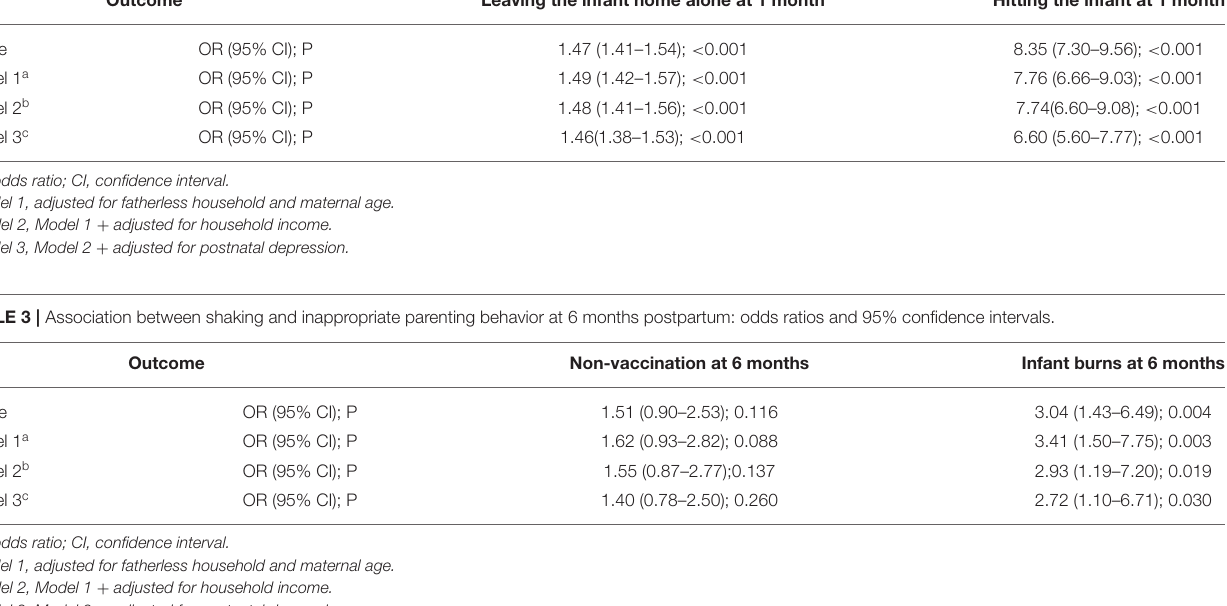
TABLE 2 | Association between shaking and inappropriate parenting behavior at 1 month postpartum: odds ratios and 95% confidence intervals. Outcome